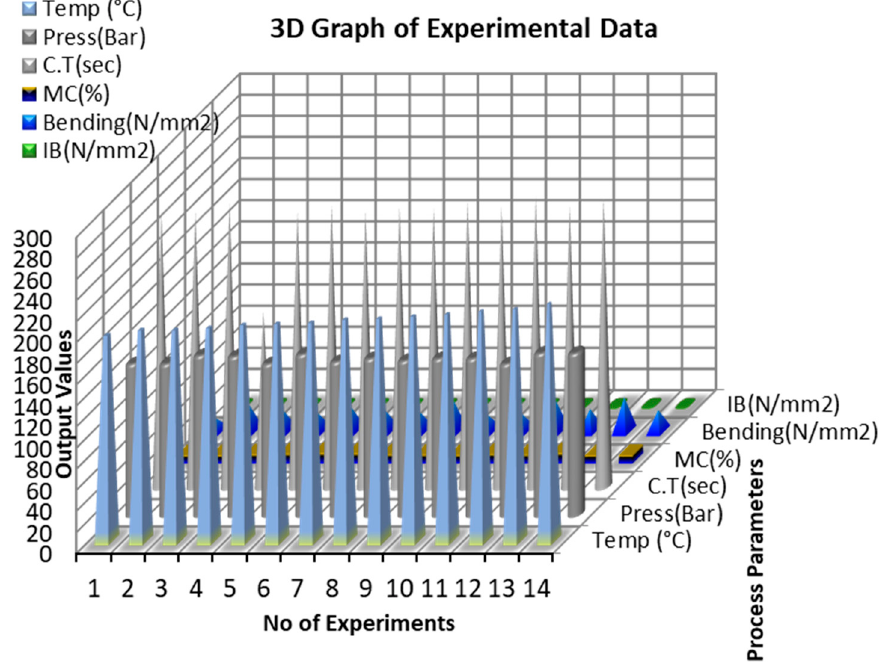
Figure 6. Three-dimensional graphical representation of experiments.